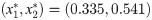
An example of continuously stable strategy.(a) Time series plots obtained through simulation of Model (9) with initial condition (x1, x2) = (0.3, 0.8) and a2 = 2.5. (b) Fitness landscape plots when (x1*,x2*)=(0.335,0.541) and a2 = 2.5. (c) Equilibrium population density of prey species as the traits (x1, x2) evolve. (d) Equilibrium population density of predator species as the traits (x1, x2) evolve. The other parameter values are the same as described in Figs 1 and 2.